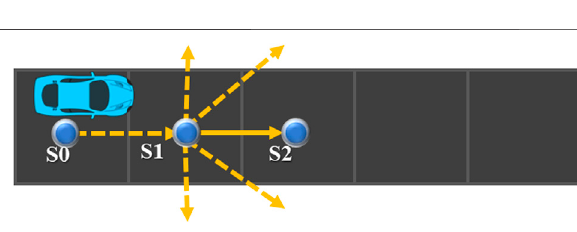
FIGURE 13 | Single expected driving